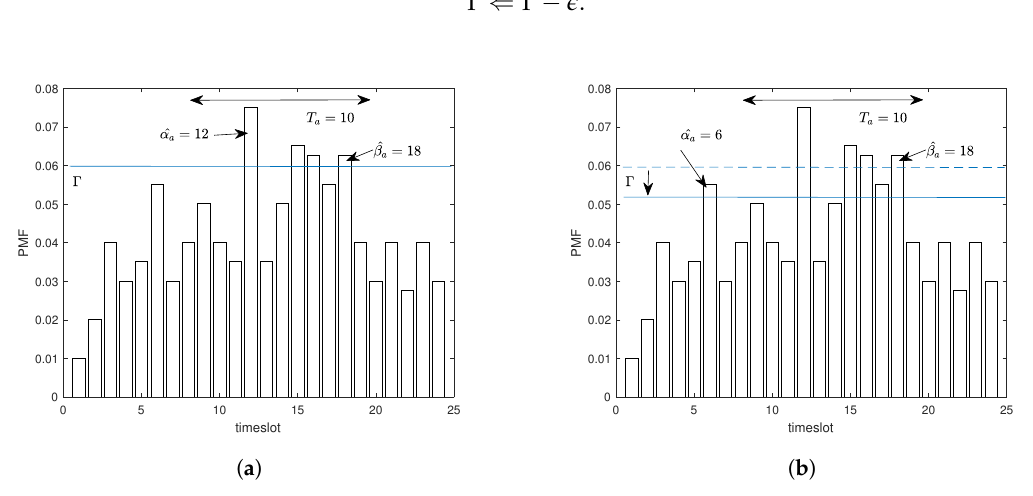
Figure 8. Example of PMF of an interruptible appliance.